Question: Judging by this figure, is the value going up or going down?
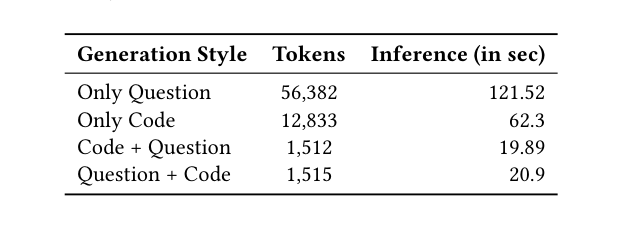
Answer: increasing